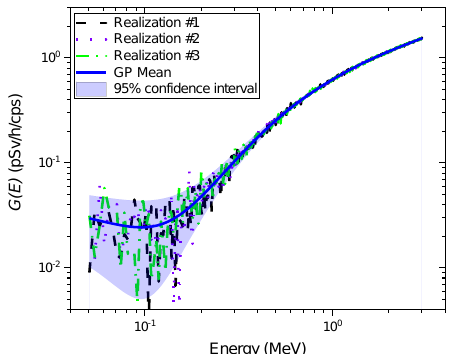
Figure 5. Example of three independent realization functions (i.e., G(E) 𝐺𝑃𝑅 functions) randomly sampled from the GP model. The solid blue line represents the mean of the GP model. The blue shaded area denotes the 95% confidence interval.